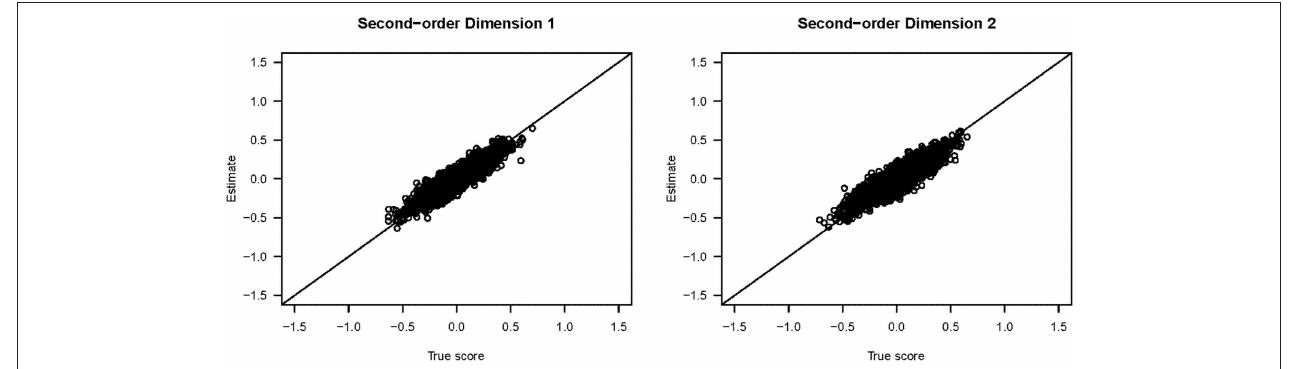
FIGURE 4 | Scatter plots of the true and estimated second-order latent trait scores from the simulation study.